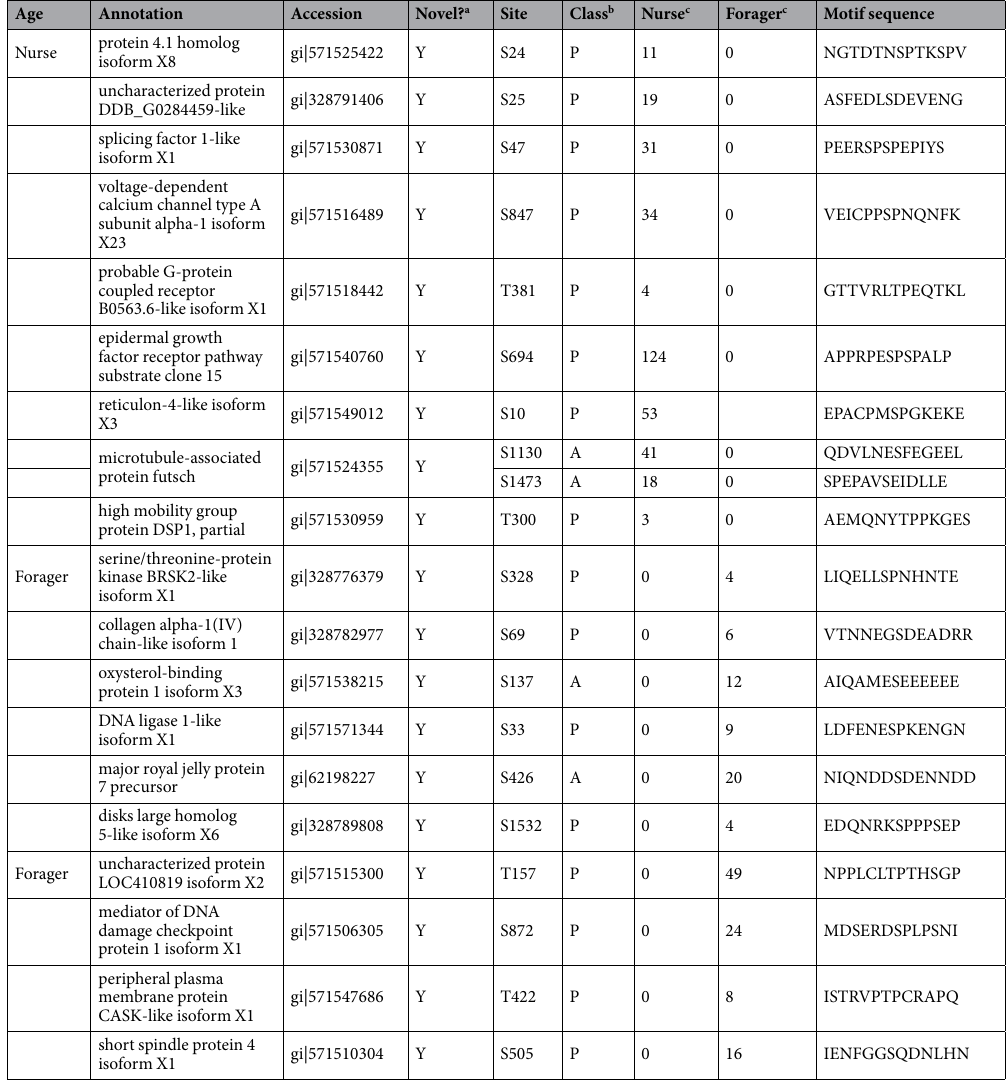
Table 1. Abundant age-specific phosphosites in worker honey bee brain at two ages as determined by spectral counts. The data in this table chooses abundant phosphosites that were found in only one of nurse and forager bee brain, listed by protein and bee of different age. Age-specific sites are shown for the two ages of the brain in honeybee workers. a Novel site is decided according whether the site has been reported with protein post-translational modifications in Apis mellifera or not. b Site class is assigned by a decision tree algorithm: A = acidic; B = basic; O = other; P = proline-directed; T = tyrosine. c Number of spectral count in a protein of nurse and forager